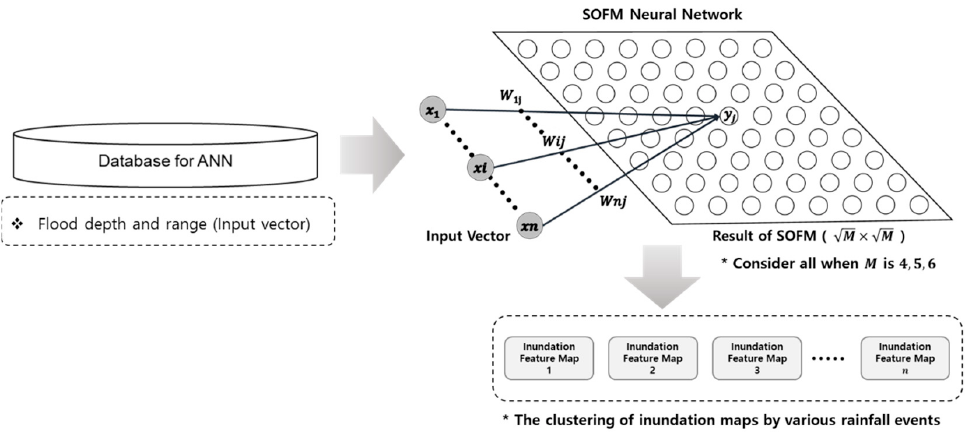
Figure 4. SOFM (Self-Organizing Feature Map) for optimization of the 2D inundation map database.